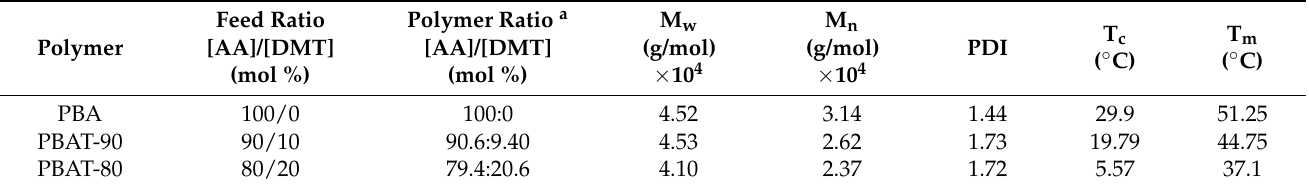
Table 1. Compositions and molecular weights of synthesized